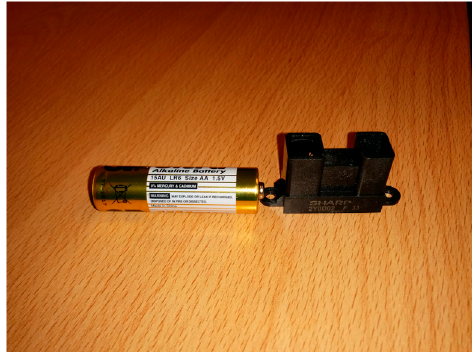
Table 1. Standard sensing modes of the sensor.